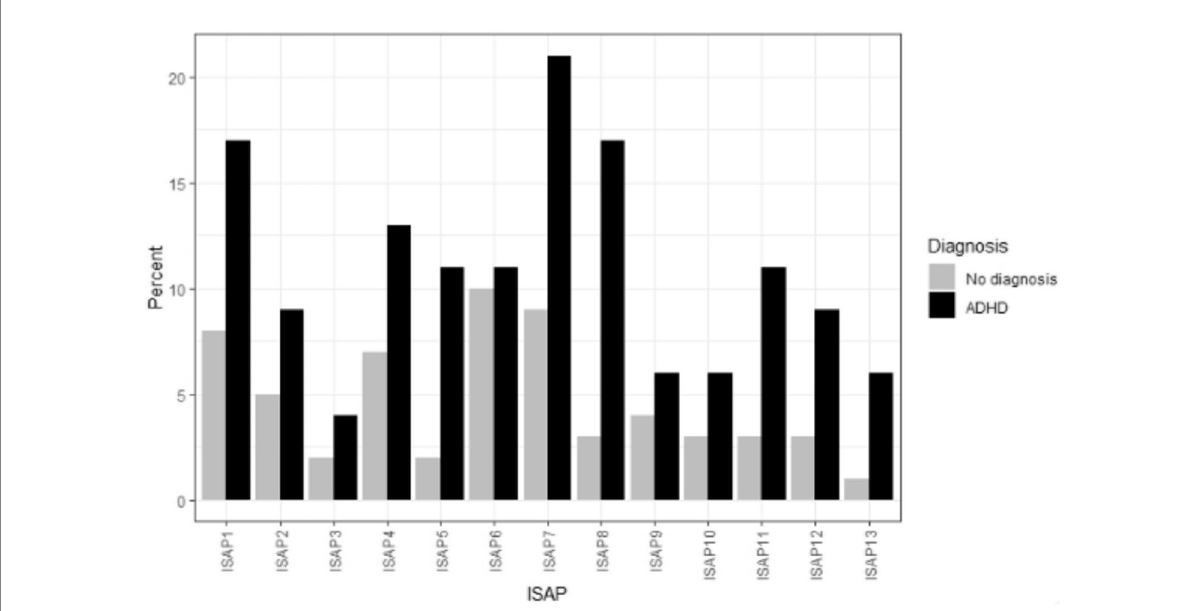
FIGURE 2 Scores indicating at least moderate influence on school attendance problems (SAP) for adolescents with and without attention deficit hyperactivity disorder (ADHD). The inventory of school attendance problems (ISAP) Function factors. The reasons for SAPs in percentages for each group per each factor in order from ISAP 1–ISAP 13: depression, social anxiety, separation anxiety, performance anxiety, agoraphobia/panic, somatic complaints, school aversion/alternatives, aggression, problems with peers, problems with teachers, dislike of the specific school, problems within the family, and problems with